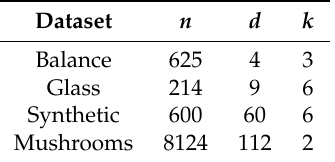
Table 1. Four UCI datasets used for experimental study.